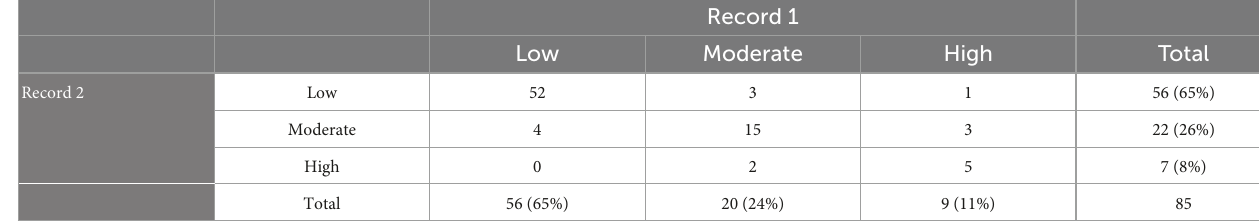
TABLE 3 Repeat reliability of IBD-NST